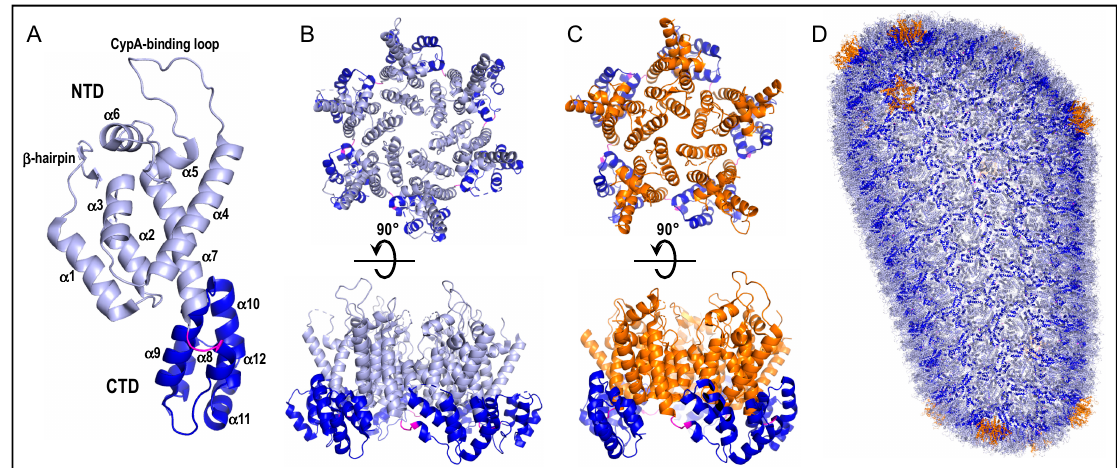
Figure 2. HIV-1 CA, capsomere, and capsid shell structures. ( A ) The structure of the CA monomer from protein data bank (PDB) entrant 4XFY [29] is color-coded to highlight the NTD (residues 1–146; light blue), interdomain linker (residues 147–149; magenta), and C-terminal domain (CTD) (residues 150–231; dark blue). Labels demarcate secondary structural ele- ments. The host factor cyclophilin A (CypA) engages CA via the CypA-binding loop [30]. ( B ) The hexameric capsomere from PDB entrant 4U0D [31]. The upper “top” view represents what would be seen from the outer surface of the core shell. Rotating this view 90° into the plane of the page yields the lower “side” view. Coloring is maintained from panel A. ( C ) The pentameric capsomere (PDB code 3P05) [32]. Upper and lower images are analogous to those in panel B. Orange is used to highlight NTDs of pentameric capsomeres; other coloring is same as panel A. ( D ) Atomic model of assembled core shell (PDB code 3J3Y). The model is composed of 186 hexameric capsomeres and 12 pentamers [33]. Coloring is same as in panels A–C.